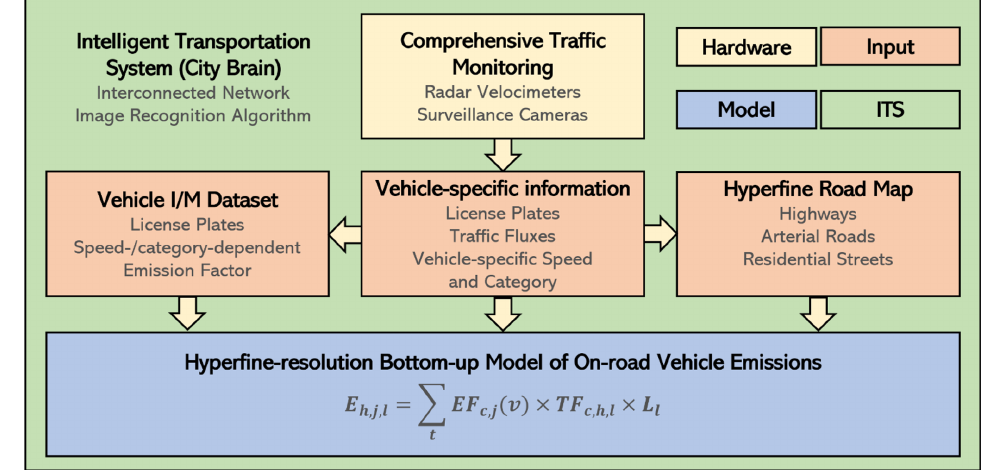
Figure 1. A hyperfine-resolution model framework for on-road vehicle emissions. Traffic monitoring includes radar velocimeters and surveil- lance cameras. License plates, speed, categories, and traffic fluxes are collected. The speed- and category-dependent emission factors are ob- tained from the local official vehicle I/M dataset. Road segments are divided into three road classes: highways, arterial roads, and residential streets. An intelligent transportation system (ITS) (named City Brain) is developed to interconnect these input data. An image recognition algorithm is embedded to recognize the category for a certain vehicle. Detailed information is given in Sect. 2.2.